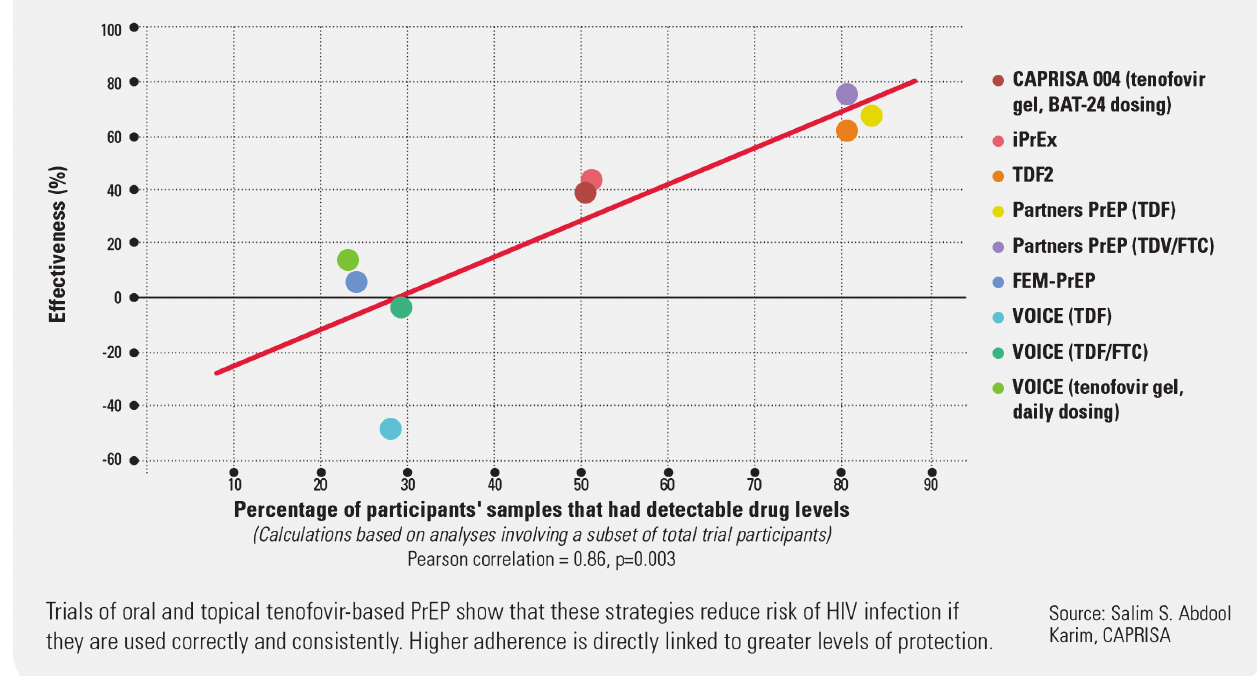
FIGURE 1: Effectiveness and adherence in trials of oral and topical tenofovir-based